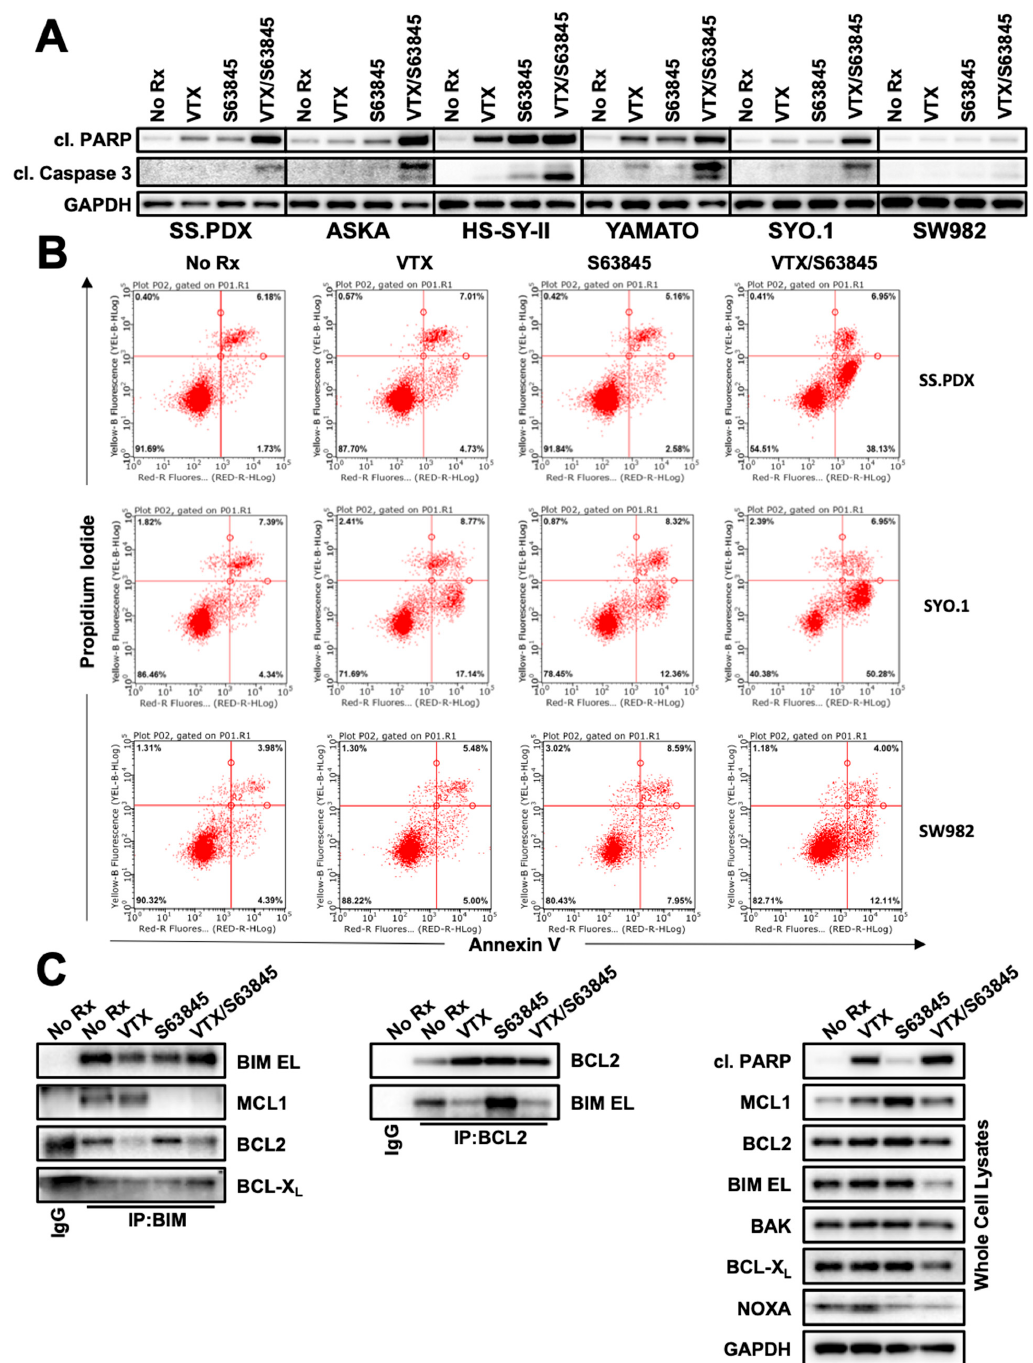
Figure 4. S63845 and VTX combine to induce apoptosis in SS cell lines. ( A ) Western blot analysis of key apoptotic markers cleaved PARP1 and cleaved caspase 3 after overnight treatment with 1 µM VTX, 100 nM S63845, or combination, in SS.PDX, ASKA, HS-SY-II, Yamato, and SW982 cell lines. ( B ) SS.PDX, SYO.1, and SW982 cell lines were treated overnight with 1 µM VTX, 100 nM S63845, or the combination and analyzed for staining of propidium iodide (y-axis) and annexin-V (x-axis). Graphs were divided into quadrants: bottom-left represents viable cells; top-left necrotic cells; bottom-right early apoptotic cells; and top-right late apoptotic cells. Representative experiment of three biological replicates is displayed. ( C ) Co- immunoprecipitation shows VTX and S63845 disrupt pro-apoptotic protein binding to BCL-2 and MCL-1, respectively; left panel: pulldown with pro-apoptotic protein BIM; middle panel: pulldown with BCL-2; right panel: whole cell